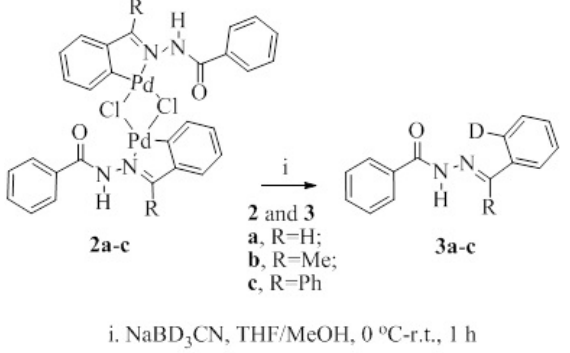
Figure 2 - Reduction of the palladacycles 2a-c